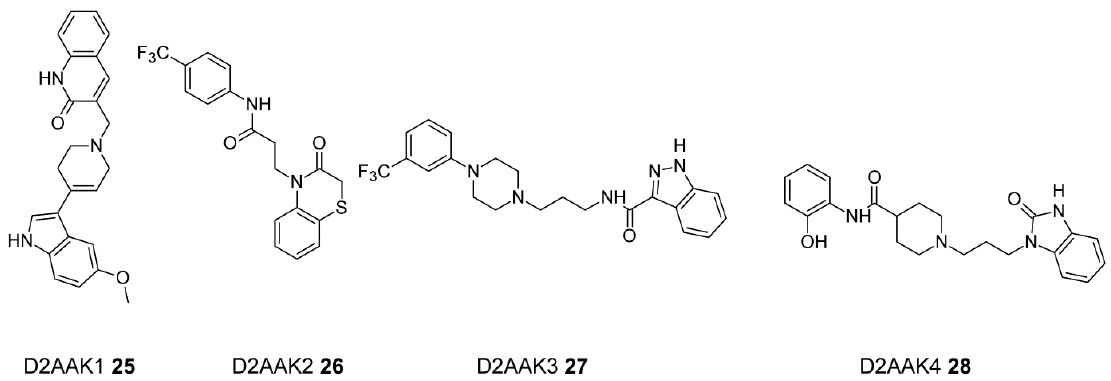
Figure 14. Multi-target compounds obtained in structure-based virtual screening.